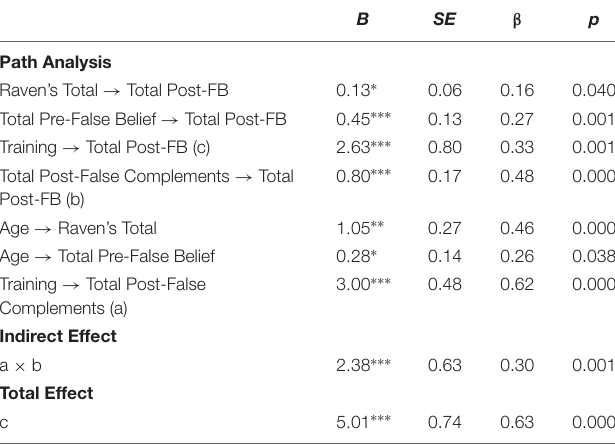
TABLE 4 | Standardized parameter estimates for the hypothesized model ( N = 60).